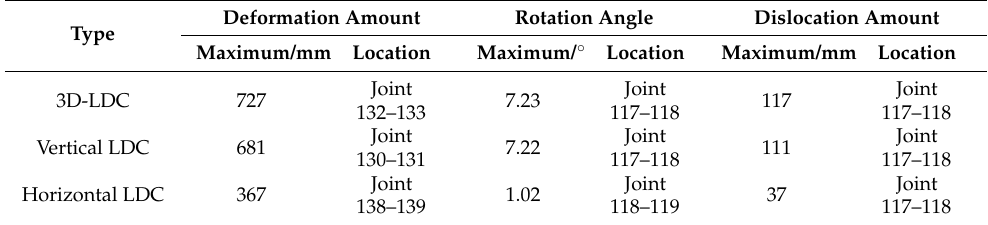
Figure 9. Experimental results of 3D-LDC. Table 2. Comparison of deformation indexes of 3D-LDC.